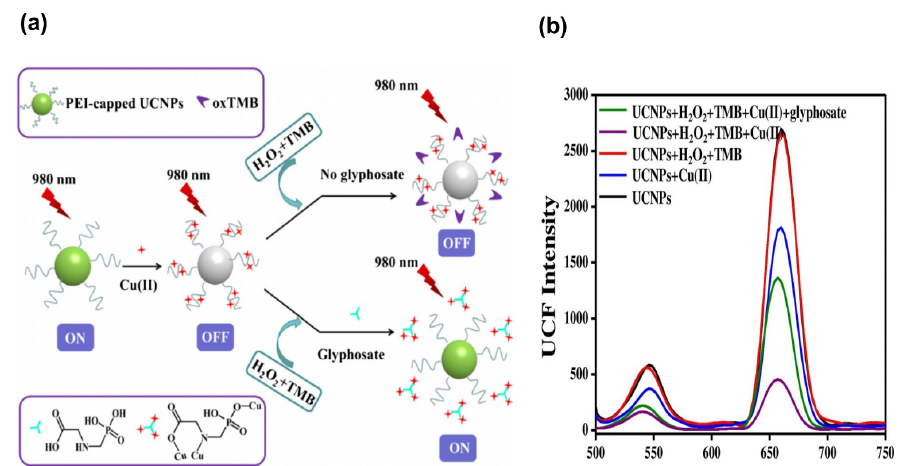
Figure 8. ( a ) Schematic representation of UCNP-H 2 O 2 -TMB-Cu (II) hybrid system for GLYP detection. ( b ) Fluorescence spectra of UCNPs (black line), UCNP-Cu(II) (blue line), UCNP-H 2 O 2 -TMB (red line), UCNP-H 2 O 2 -TMB-Cu(II) (purple line), UCNP-H 2 O 2 -TMB-Cu(II)-GLYP (green line). Reprinted with permission from [114]. Copyright 2019 Springer.